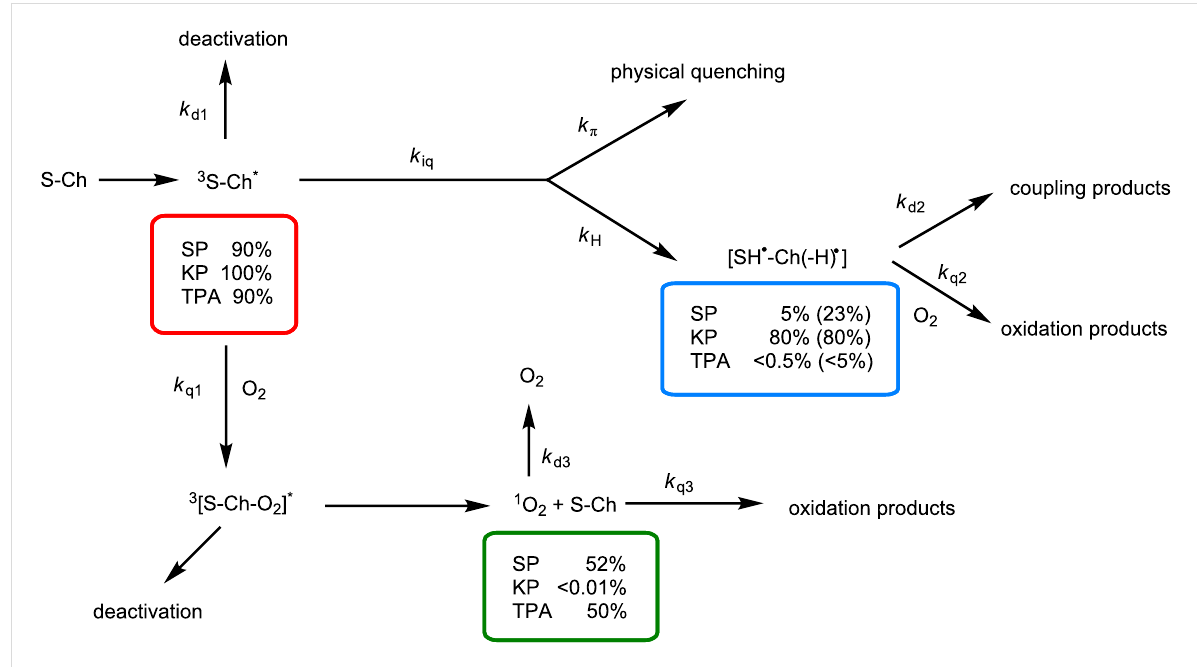
Scheme 2: Photoreaction pathways generating biradical and singlet oxygen species of a sensitizer (S), like SP, KP or TPA, covalently linked to Ch. The obtained percentages under anaerobic conditions are given in parenthesis.